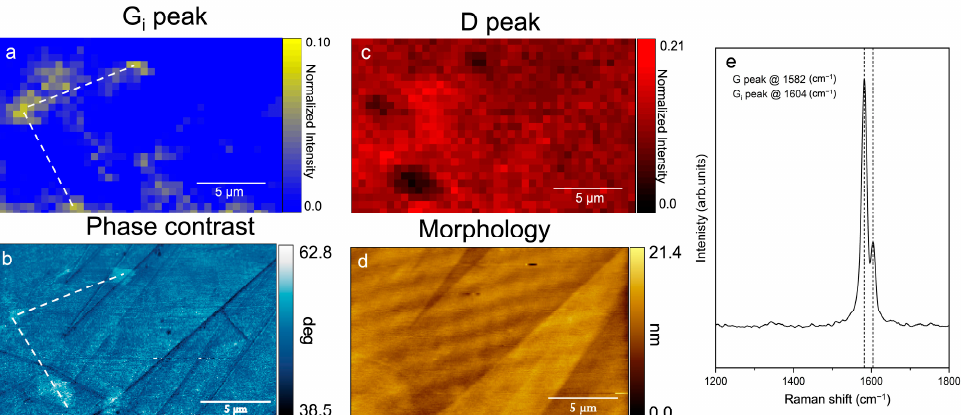
Figure 6. A (12 × 20) µ m 2 G i intensity peak map ( a ) compared to the AFM phase-contrast image ( b ), the D intensity peak map ( c ) and the AFM morphology ( d ) acquired simultaneously in situ and in the same sample area. The Raman spectrum ( e ) is collected on the brighter areas of ( b ). All the Raman maps show normalized data with respect to the G peak intensity.